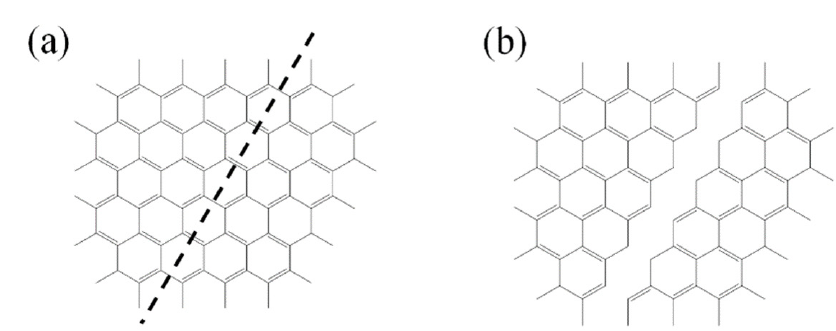
Figure 5: Hydrothermal cutting (deoxidization) of graphene. (a) before, and (b) after (Bandara et al ., 2022a).